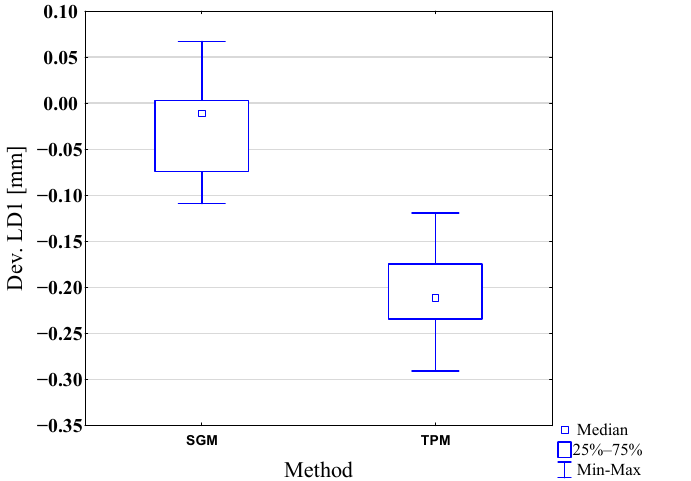
Figure 3. Comparison of deviations of the linear dimension 1 for SGM and TPM methods.